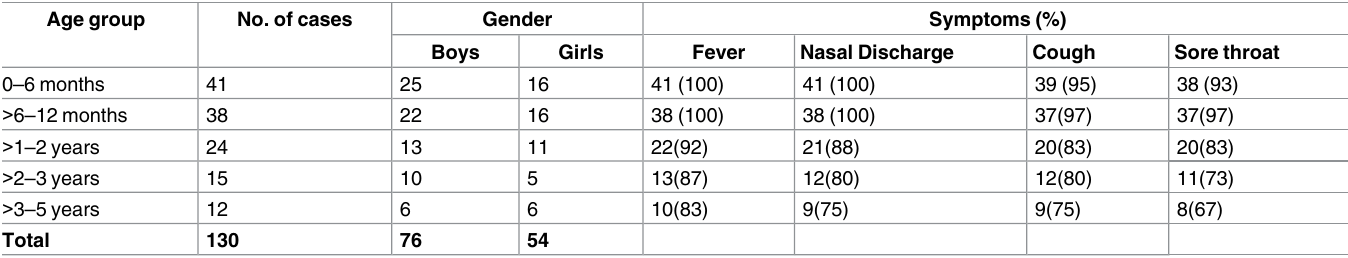
Table 1. Clinical manifestations of the study patients. Age